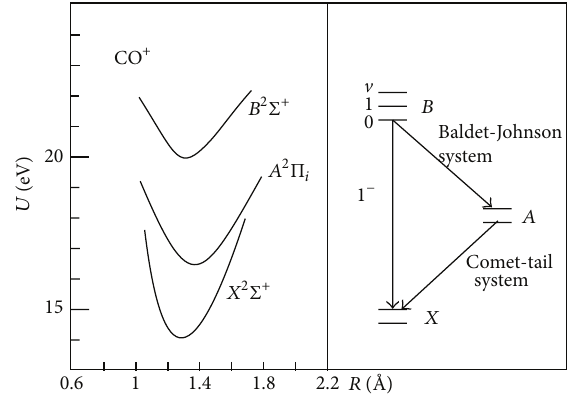
Figure 4: Dependence of intensity of the 508.6 nm line on the vapor density of cadmium in the 3 He-Xe-Cd mixtures. Open circles— calculation by formula (20) for 𝐼 ∞ = 200 units, 𝑘 = 10 −13 cm 3 s −1 .